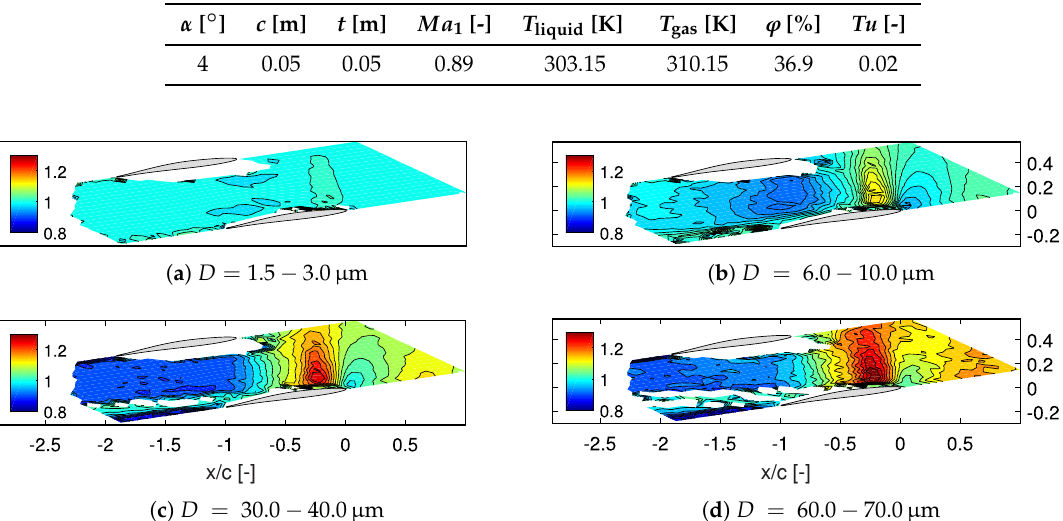
Figure 3. Measured absolute velocity contour across te passage. Ma 1 = 0.89, α = 4 ◦ . Table 1. Summary of test rig and influencing parameters.